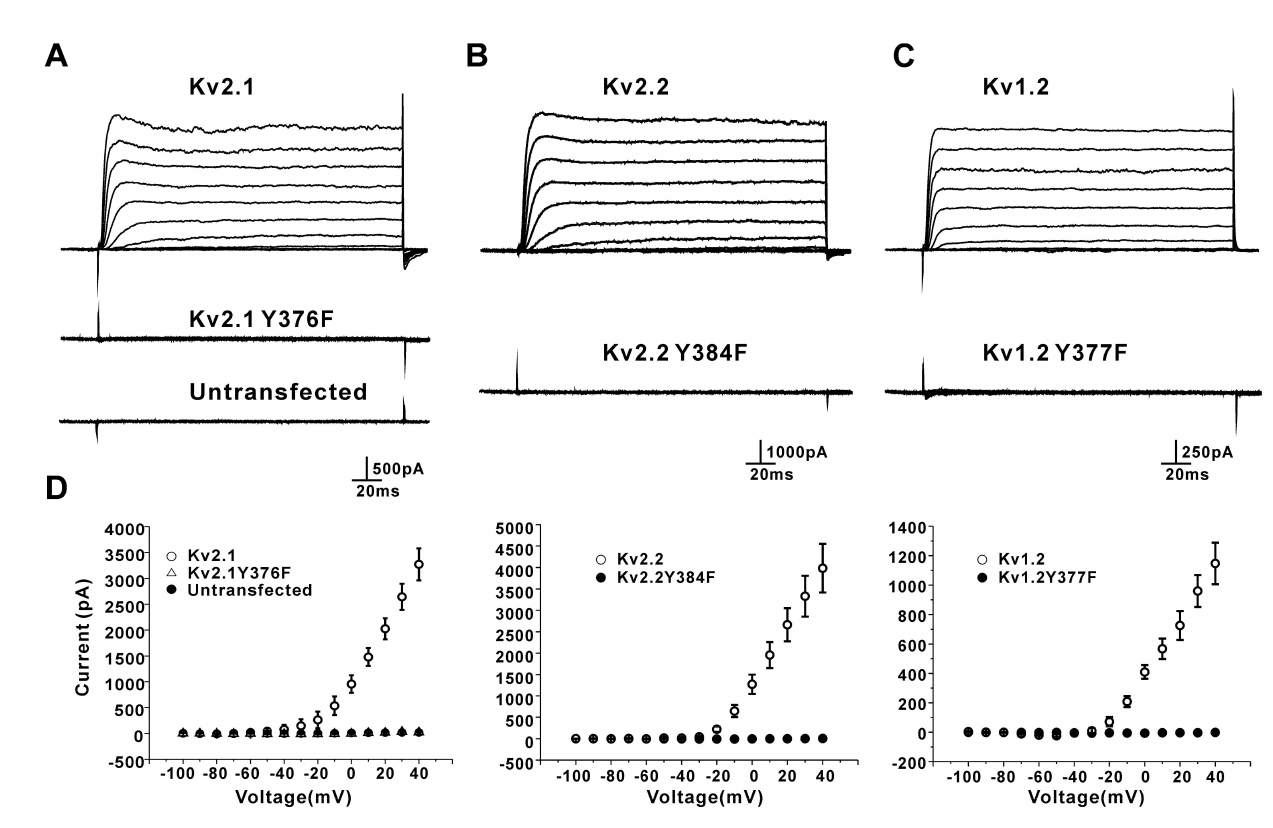
Figure 6. Effects of the mutation of the conserved tyrosine residue on the Kv2.1, Kv2.2, and Kv1.2 channels in HEK293 cells. ( A ) Y376F (Kv2.1) mutant channels present no obvious outward currents. HEK293 cells present no obvious endogenous outward currents. ( B , C ) Y384F (Kv2.2) and Y377F (Kv1.2) mutant channels present no obvious outward currents. Currents are elicited by a step protocol (holding at − 100 mV and depolarizing in 10-mV steps from − 100 to +40 mV at 10-s intervals). ( D ) I-V plots of the outward currents of Kv2.1, Kv2.2, and Kv1.2 wild-type and mutant channels ( n =